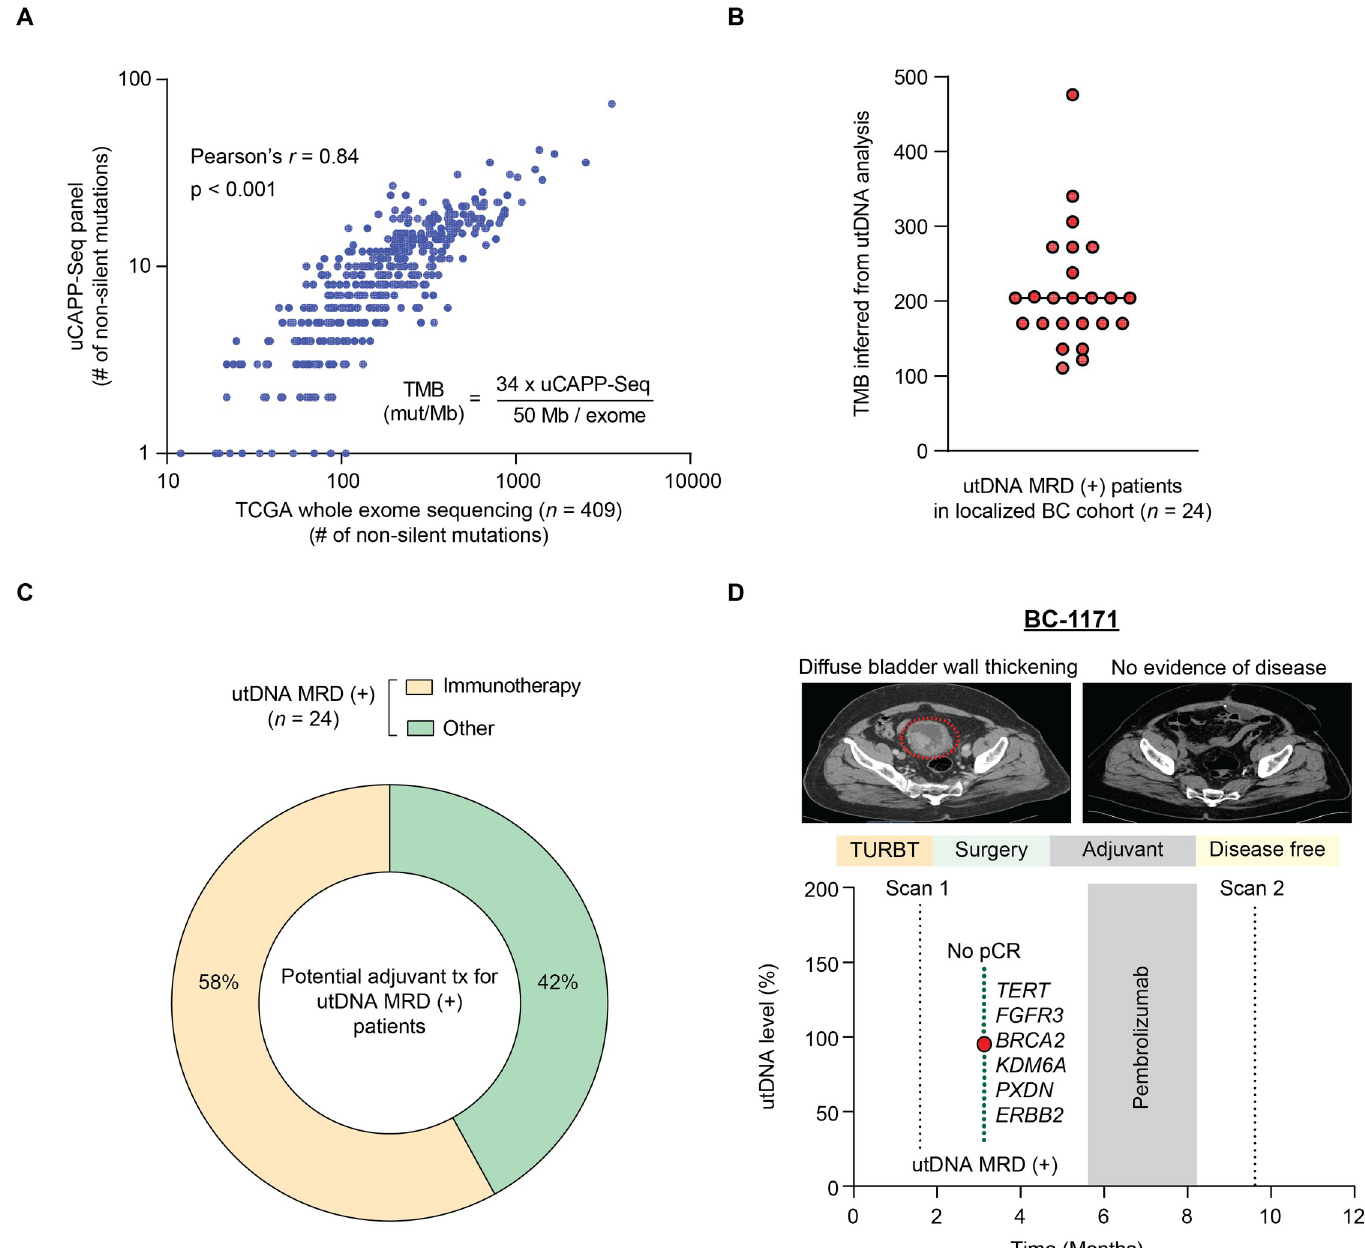
Fig 5. utDNA MRD as a biomarker for adjuvant treatment personalization. (A) Comparison of non-silent mutational load detected by whole exome sequencing and uCAPP-Seq for MIBC cases in TCGA ( n = 409), using an expanded gene panel for assessing TMB (referred to as the TMB panel; S3 Table ). Linear regression was performed (Pearson’s r = 0.84; equation shown) to interpolate exome-wide TMB based on the number of non-silent mutations detected by uCAPP-Seq. (B) Scatter plot depicting inferred TMB among patients with positive utDNA MRD in our cohort with the median indicated by a horizontal black line. (C) Potential adjuvant treatment strategies for utDNA MRD (+) patients based on urine-inferred TMB. (D) Vignette depicting MIBC patient BC-1171 who was utDNA MRD (+) at the preoperative time point, concordant with no pCR on surgical pathology with evidence of locally advanced pT3a disease (AJCC 8). Six non-silent mutations were detected in preoperative urine from this patient as indicated. Urine-inferred TMB was elevated at 204. This patient was randomized to pembrolizumab on a clinical trial and has shown no evidence of disease on long-term follow-up, consistent with our prediction for a patient with high inferred TMB. AJCC 8, American Joint Committee on Cancer 8th edition; MIBC, muscle-invasive bladder cancer; MRD, minimal residual disease; pCR, pathologic complete response; TCGA, The Cancer Genome Atlas; TMB, tumor mutational burden; TURBT, transurethral resection of bladder tumor; tx, treatment; uCAPP-Seq, urine Cancer Personalized Profiling by Deep Sequencing; utDNA, urine tumor DNA.